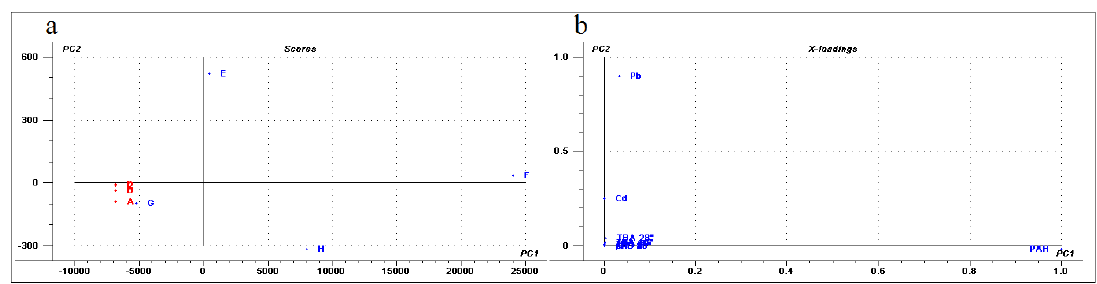
Figure 6. Principal Component Analysis. The analysis was performed with the software “The Unscrambler”. ( a ) The soil samples projected in the first two components (score plot). Each sample was colored according to their condition, red (control) or blue (exposed to diesel). ( b ) The value of the variable coefficient for the first two components (loading plot) using values of heavy metal concentrations, PAH concentration, phenanthrene-degrading isolates and TBA at different temperatures.